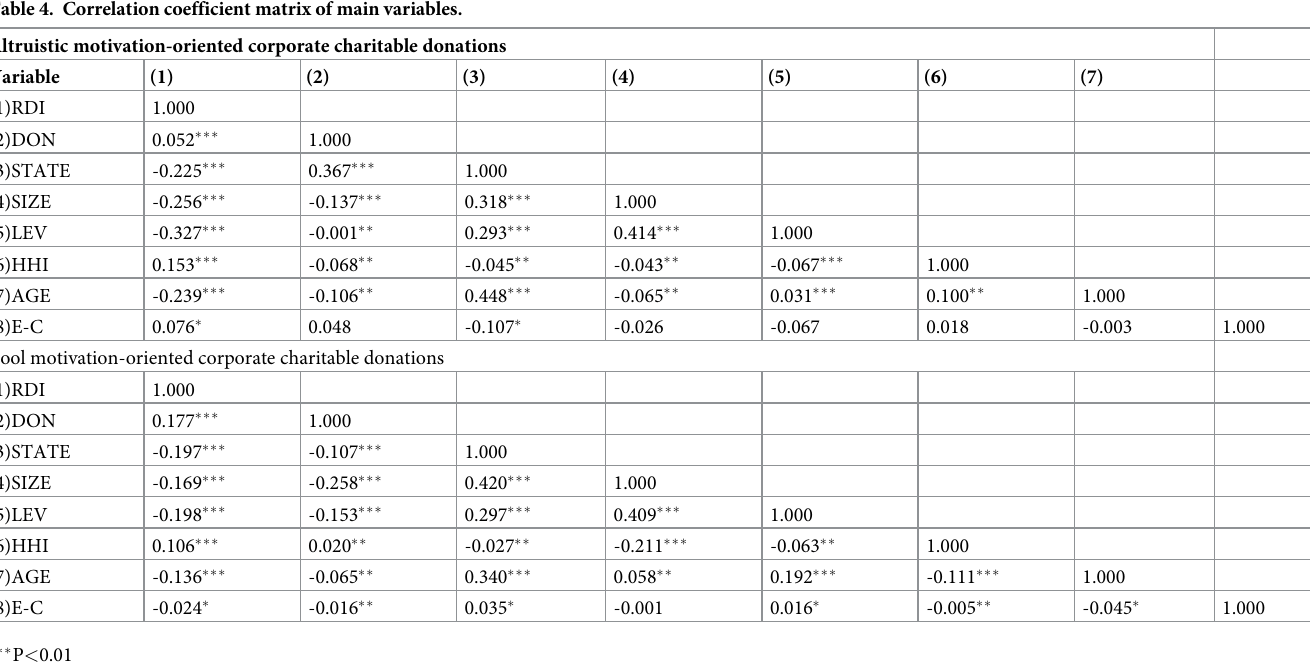
Table 4. Correlation coefficient matrix of main